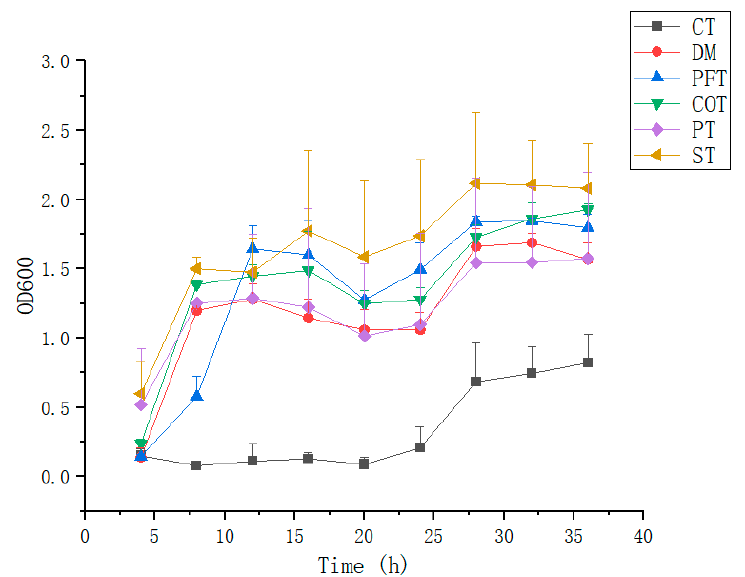
Figure 1. Growth curve of strain Bacillus sp. TTMP20 using molasses with different treatment methods as carbon source. Molasses with different treatment methods (170 mL/L) was added into culture medium. The growth contained two stages (47 ◦ C from 0 h to 24 h, 60 ◦ C from 24 h to 36 h). DM corresponds to untreated molasses. ST, PT, PFT, COT and CT represent sulfuric acid treatment process, phosphoric acid treatment process, potassium ferrocyanide treatment process, calcium phosphate tribasic treatment process, combinational treatment process, respectively. Data were obtained from triplicate tests and shown as mean ± SD.